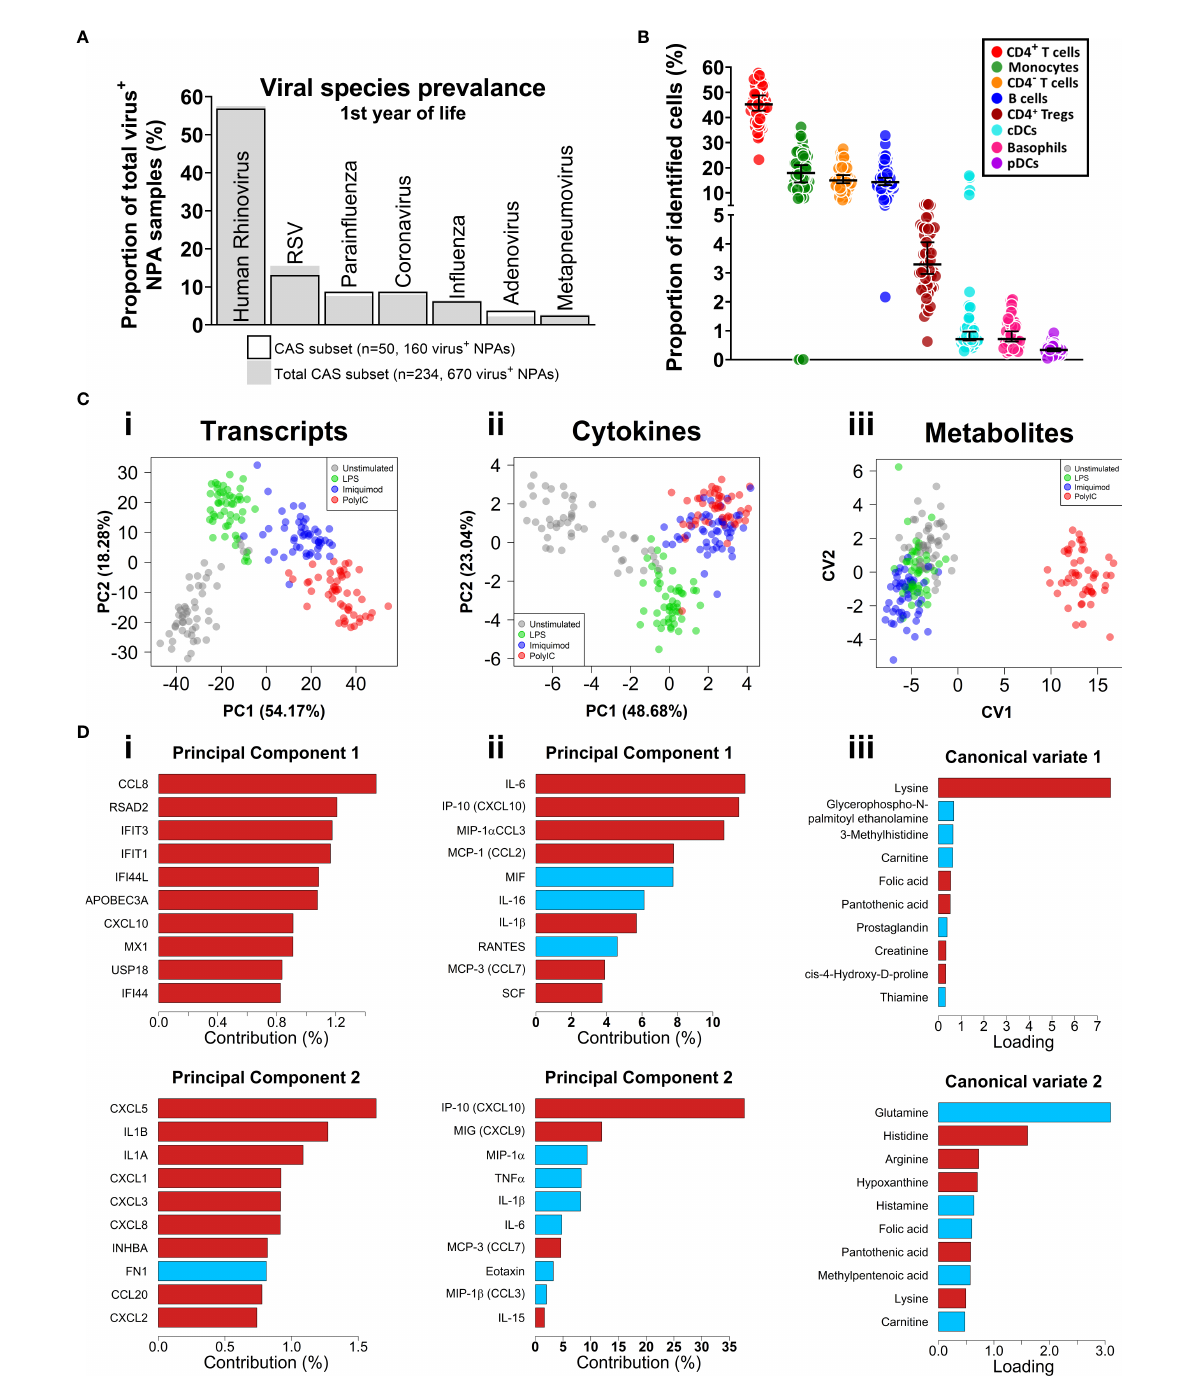
FIGURE 1 Respiratory virus prevalence, baseline CBMC cell proportions, multi-omic data set overview. (A) Bar plot of viral agents detected from infectious NPAs taken during year one (proportion of total virus + NPAs). Bars denote study subset (n=50), grey fi ll represents individuals who recorded an sLRI in year 1 from the total cohort (n=234). (B) Immunophenotyping of baseline CBMC samples. Y-axis shows cell type as a proportion of identi fi ed cells. Scatterplots shows median and 95% CI. (C) Multi-level dimensionality reduction for gene expression (PCA), cytokine (PCA), and metabolite (cross validated CVA) datasets. Axes show coordinates of the fi rst (x-axis) and second (y-axis) components/variates. (D) Horizontal bar plots showing top contributing features for the fi rst (i-iii) and second (iv-vi) principal components or canonical variates for the corresponding plots in (C) , above. X-axis shows absolute contribution (%)/loading; red/blue indicates positive/negative relative